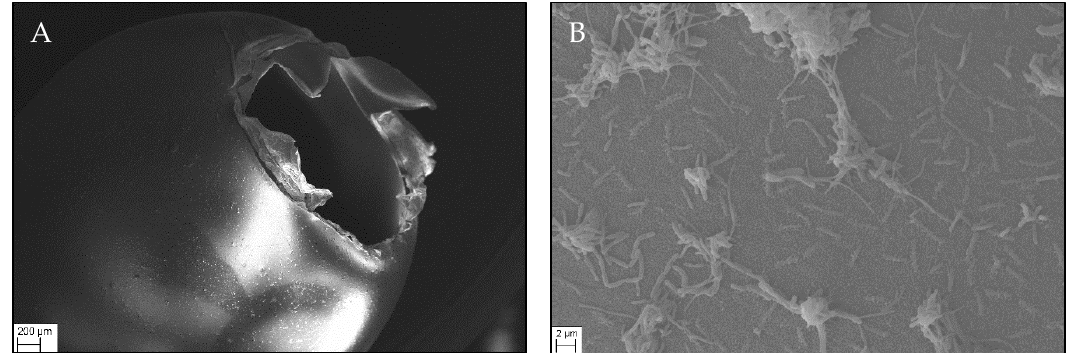
Figure 2. SEM images of the chorion of a recently hatched brown trout. (a) : Overview with distinguishable layers at the opening. ( b) : Detailed view of the chorion’s surface. No pores in µm range are present. Table 1. Summary of data for the investigated endpoints in experiment 1a. All data are given as arithmetic means ± standard deviation.